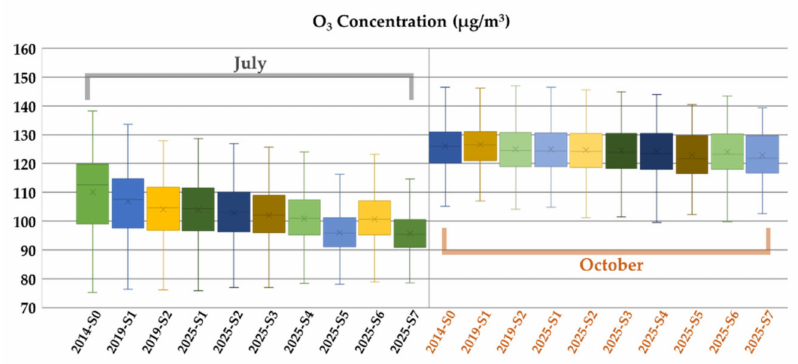
Figure 6. O 3 concentrations in each scenario in July and October.